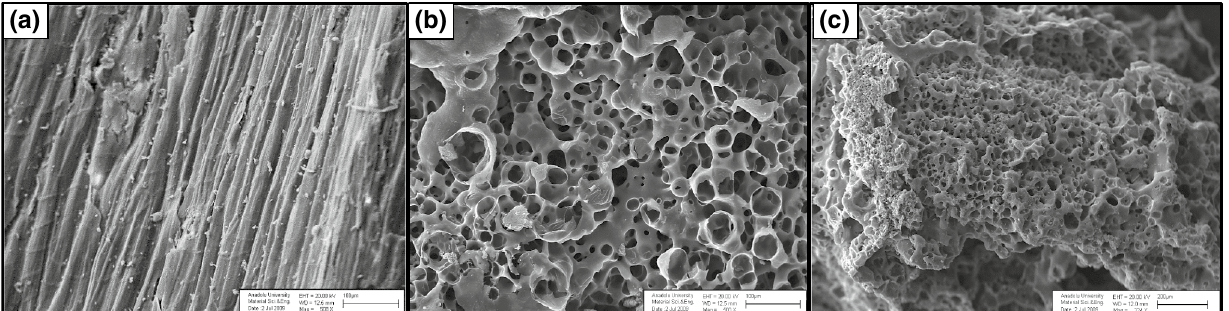
Fig. 4 SEM images of a raw chickpea straw, b KOH activated carbon, c K